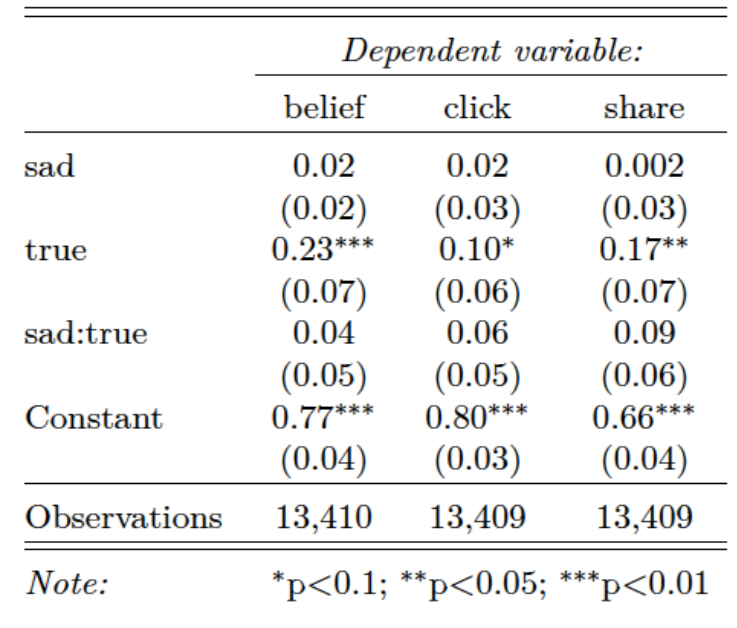
Table B6. Association between sad and belief, click, and share.